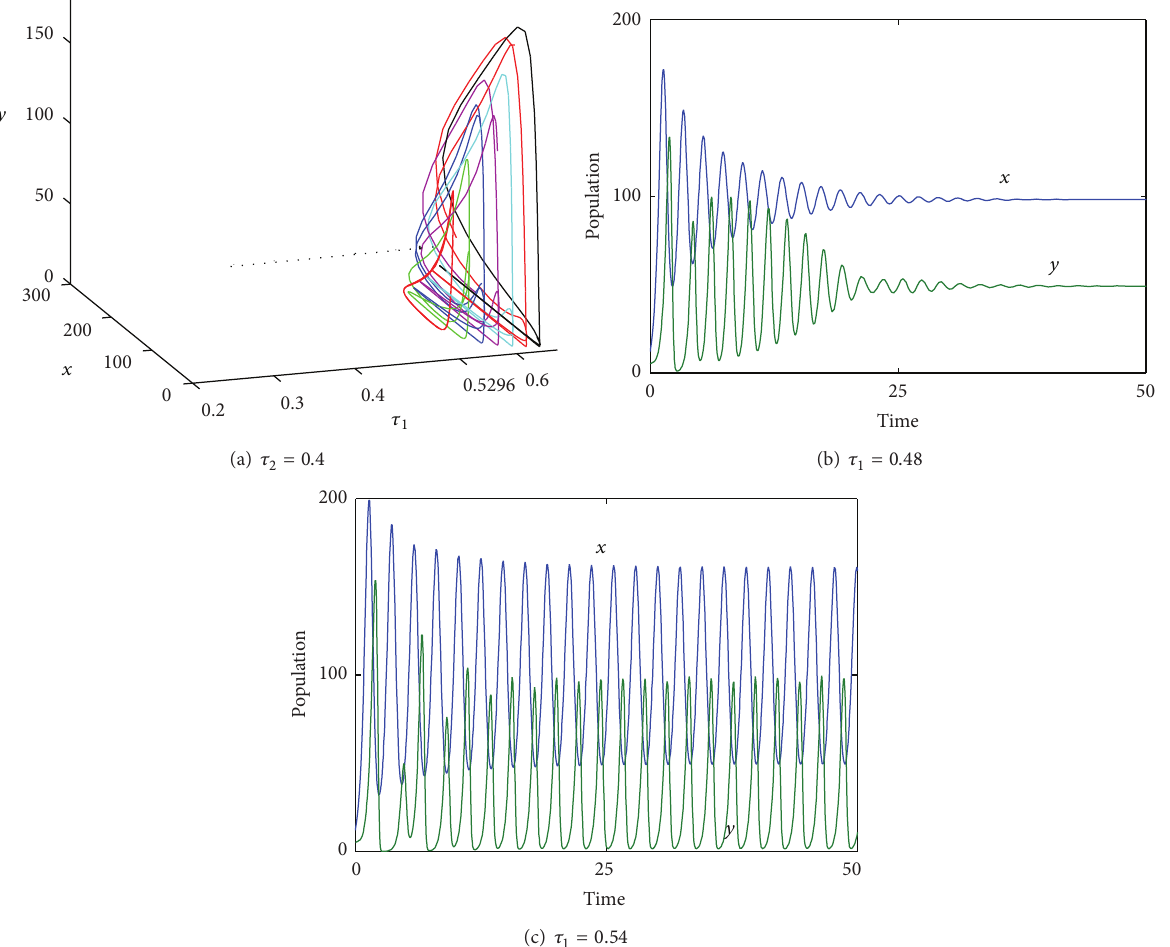
Figure 5: Bifurcation diagram of the system (3) with respect to 𝜏 1 in Case 5. (a) is drawn in the three-dimensional space (𝜏 1 ,𝑥,𝑦) . (b) and (c) are the time evolutions for 𝜏 1 = 0.48 < 𝜏 1 Hopf bifurcation exists at 𝜏 1 = 0.5296 . Here, 𝜏 2 = 0.4 ∈ [0, 0.4205) .